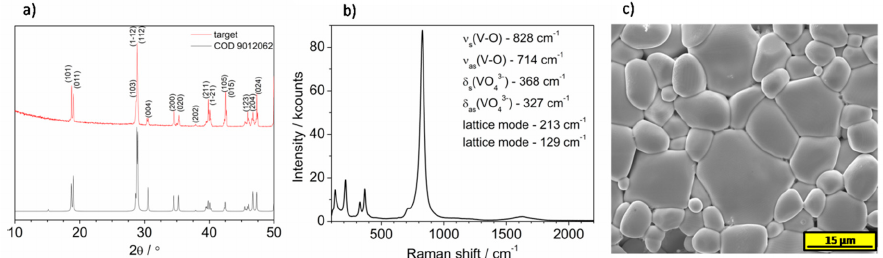
Figure 1. ( a ) The comparison of XRD patterns of target and reference pattern of BiVO 4 (from crystallography open database 9012062). ( b ) The Raman spectrum of BiVO 4 target. ( c ) SEM micrograph of annealed BiVO 4 target.